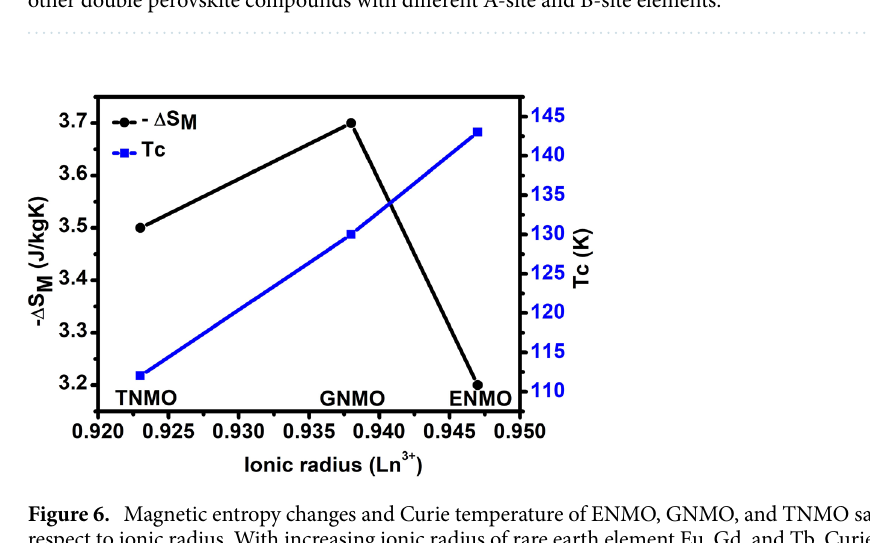
Table 2. Comparison of – ΔS M and RCP values for the R 2 NiMnO 6 (R = Eu, Gd, Tb, Dy, Ho, Er) samples and other double perovskite compounds with different A-site and B-site elements.